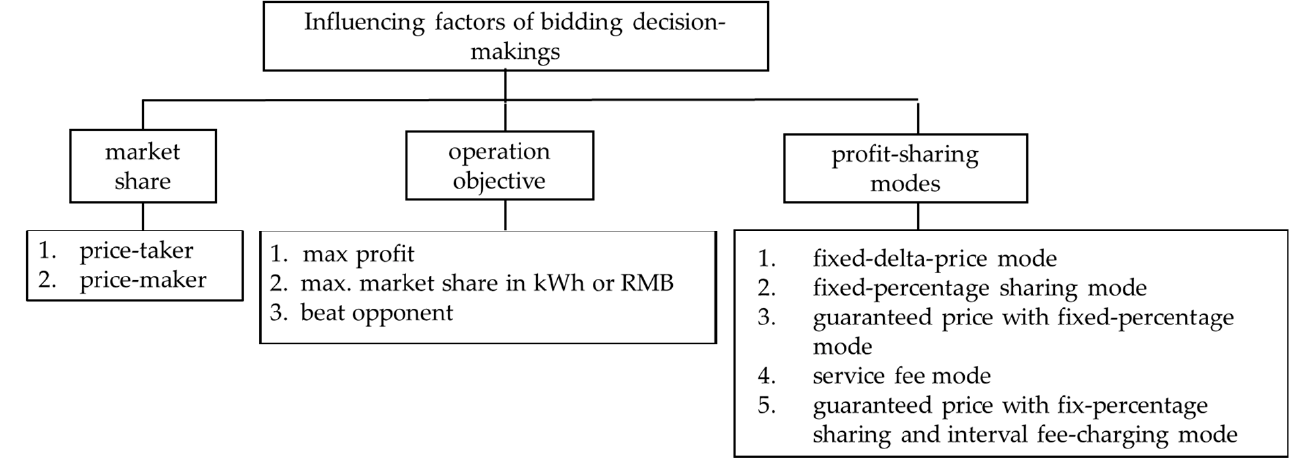
Figure 3. Influencing factors of bidding decision-makings.